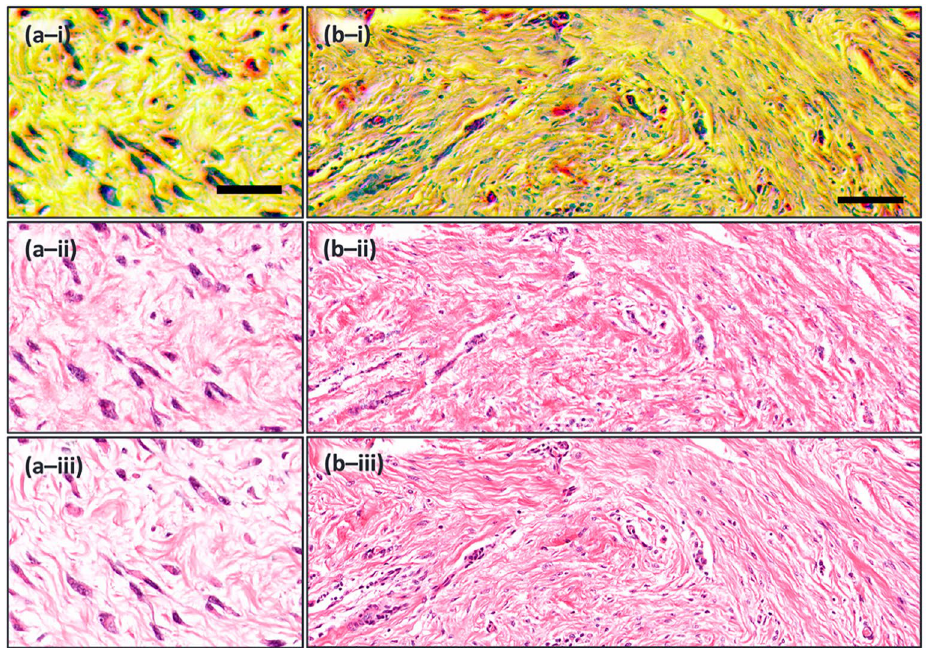
Figure 7. Virtual staining results of different parts of human skin tissue using unseen data. ( a ) Magnified image of connective tissue. Scale bar 25 µm. ( b ) Image of dense irregular connective tissue. Scale bar 100 µm. (i) Raw TA-PARS. (ii) H&E-like TA-PARS. (iii) True H&E. Image sets ( a ) and ( b ) depicts high visual agreement, especially of nuclear structures, between the H&E and the virtual